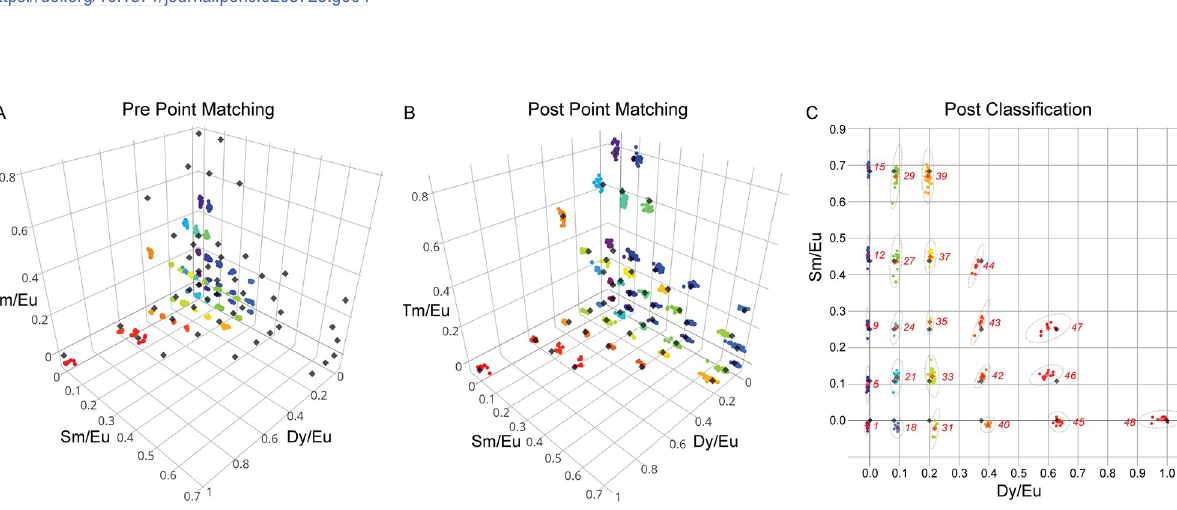
Fig 5. Code-ratio clusters prior and post alignment. Grey points are target points. Colored points are identified clusters. A) 3D scatter graph with clusters before point matching. B) 3D scatter graph with clusters after point matching, using Iterative Closest Point matching. C) 2D plot depicting post-classification code clustering and the per cluster 95%confidence interval (dotted